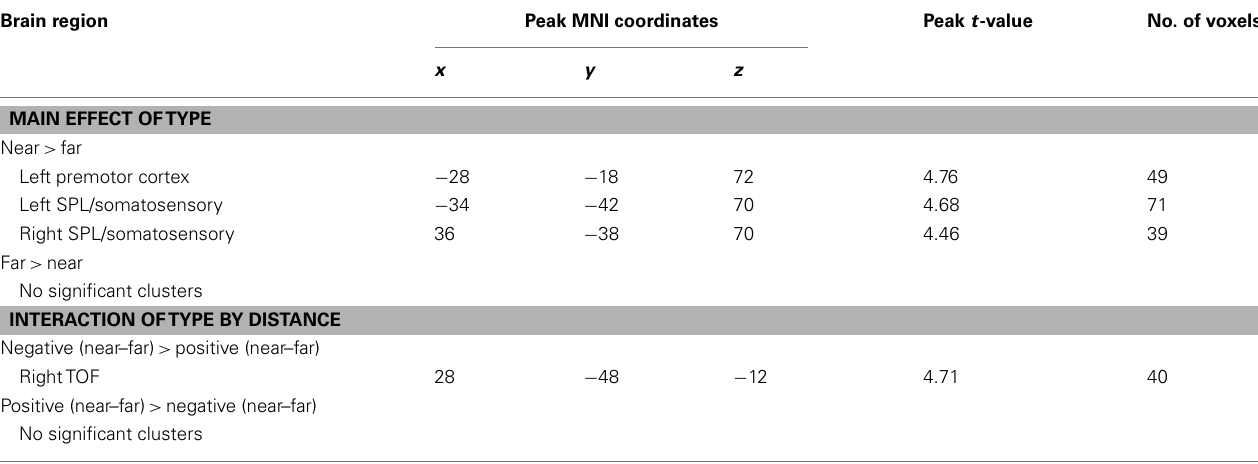
Table 3 | Brain areas that showed an effect of distance and an interaction of number type by distance. Brain region Peak MNI